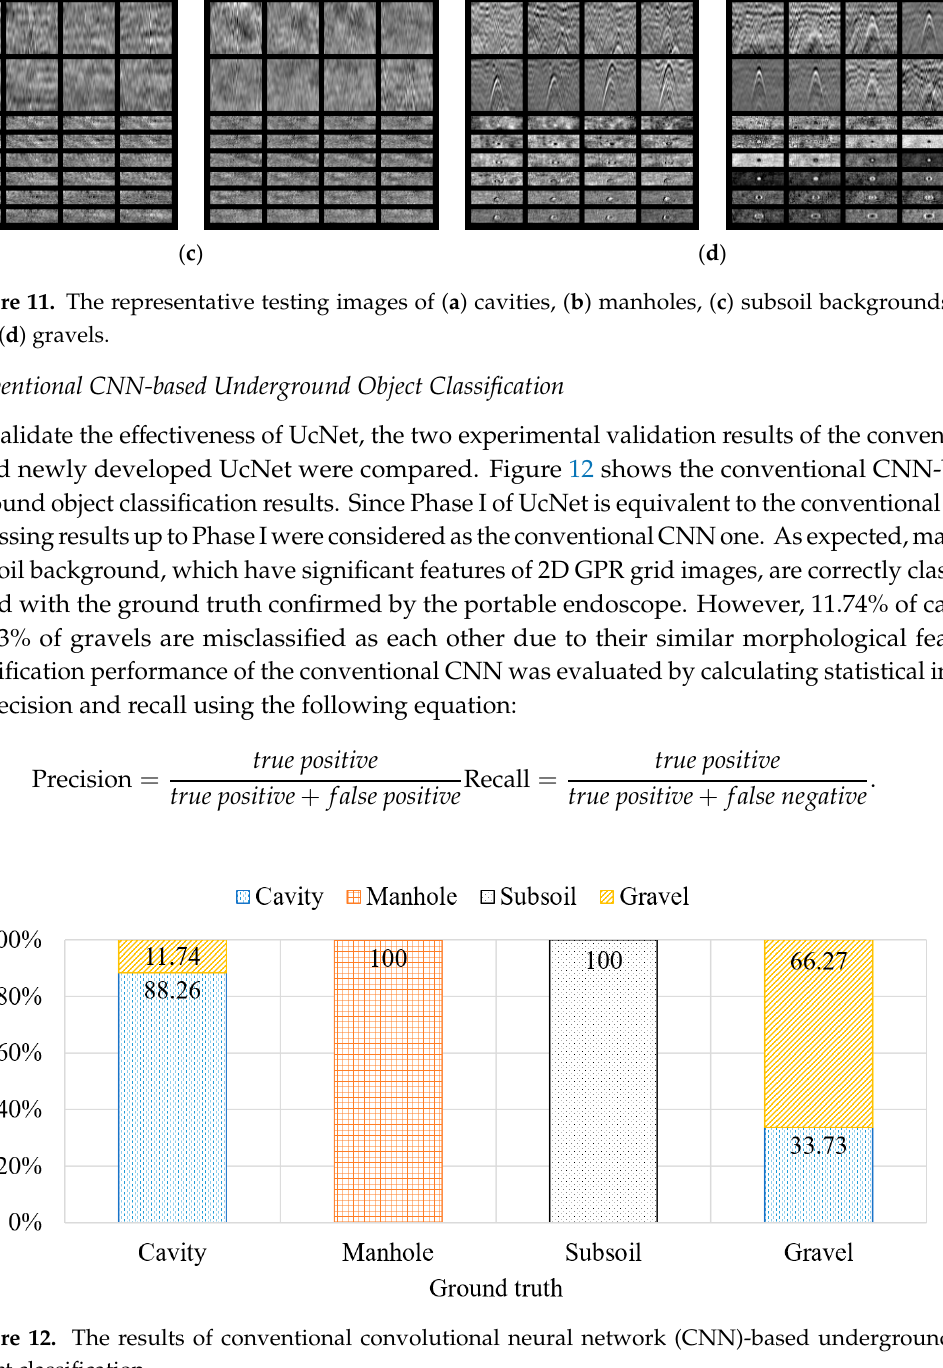
Table 1. Statistical results obtained from conventional CNN.